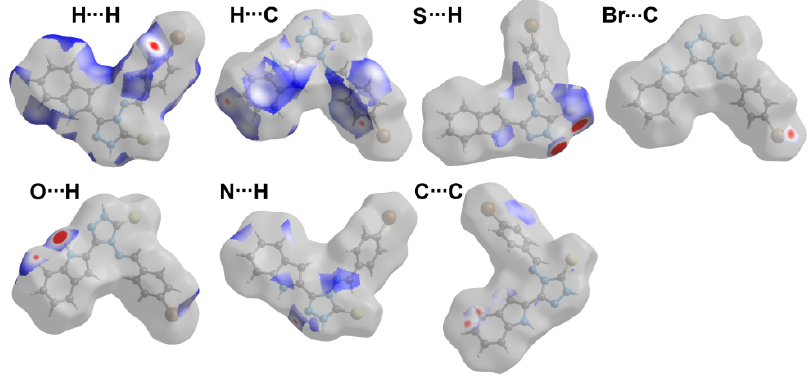
Figure 6. Decomposed d norm maps of the most important contacts in 3 . Table 4. Most important contacts and the corresponding shortest interaction distances.